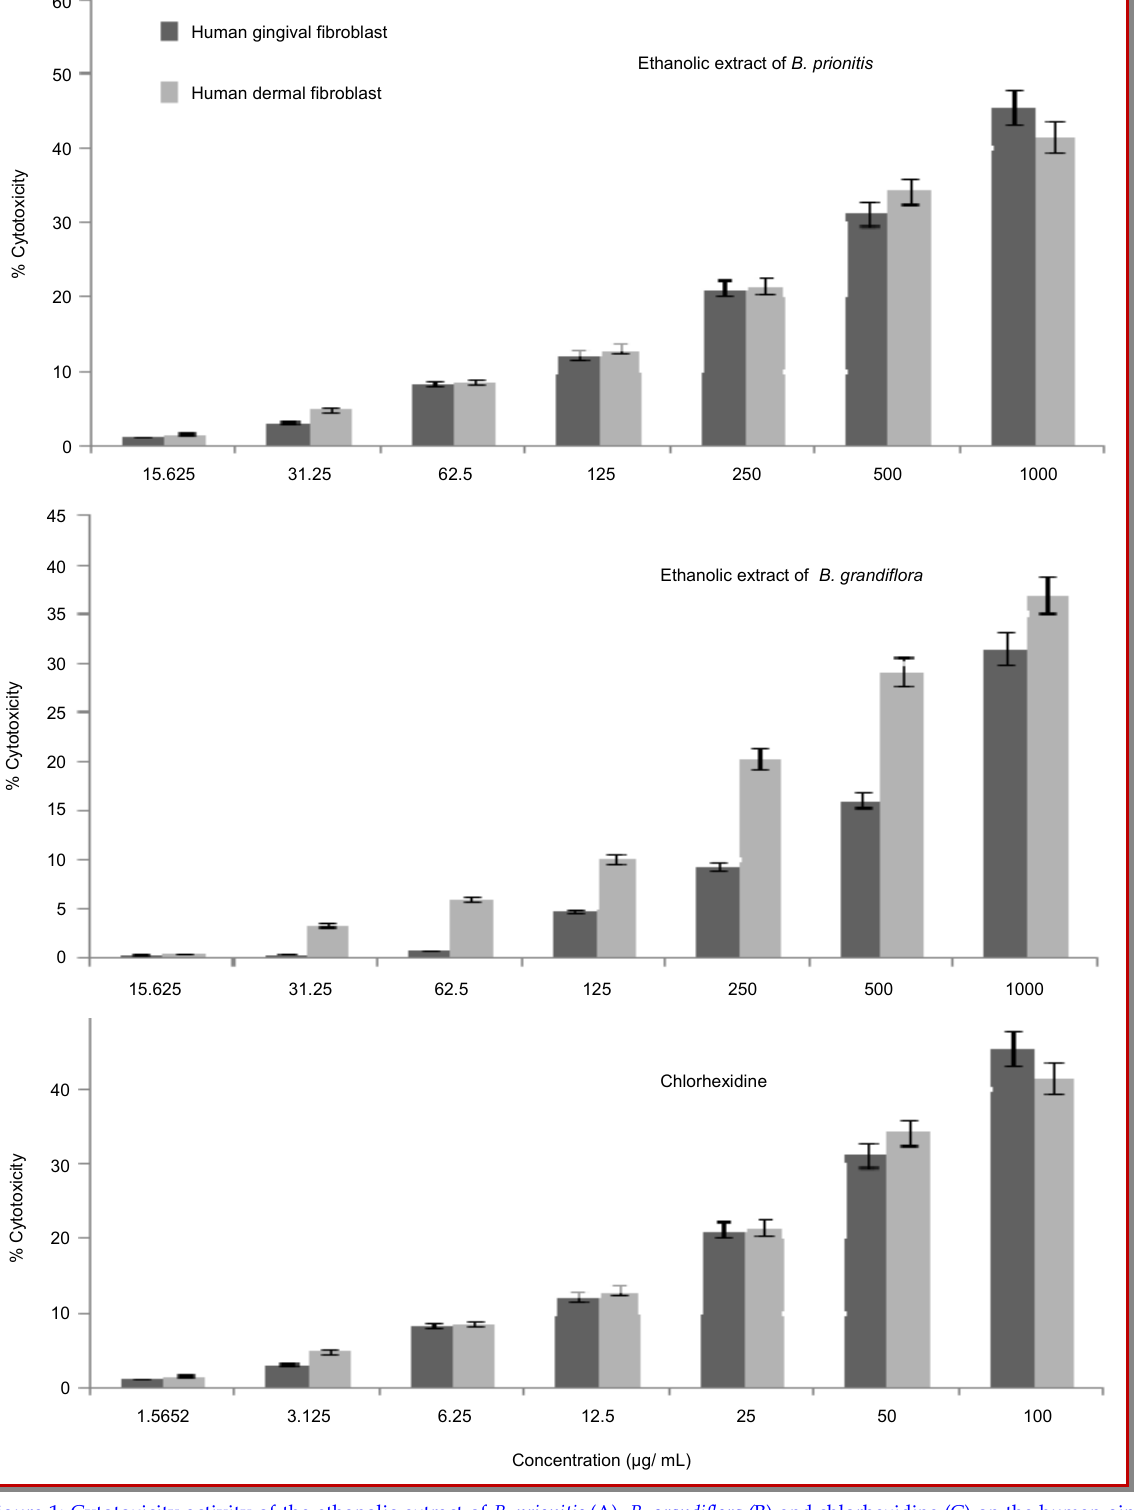
Figure 1: Cytotoxicity activity of the ethanolic extract of B. prionitis (A), B. grandiflora ( B) and chlorhexidine (C) on the human gin- gival fibroblast and human dermal fibroblast cell lines by MTT